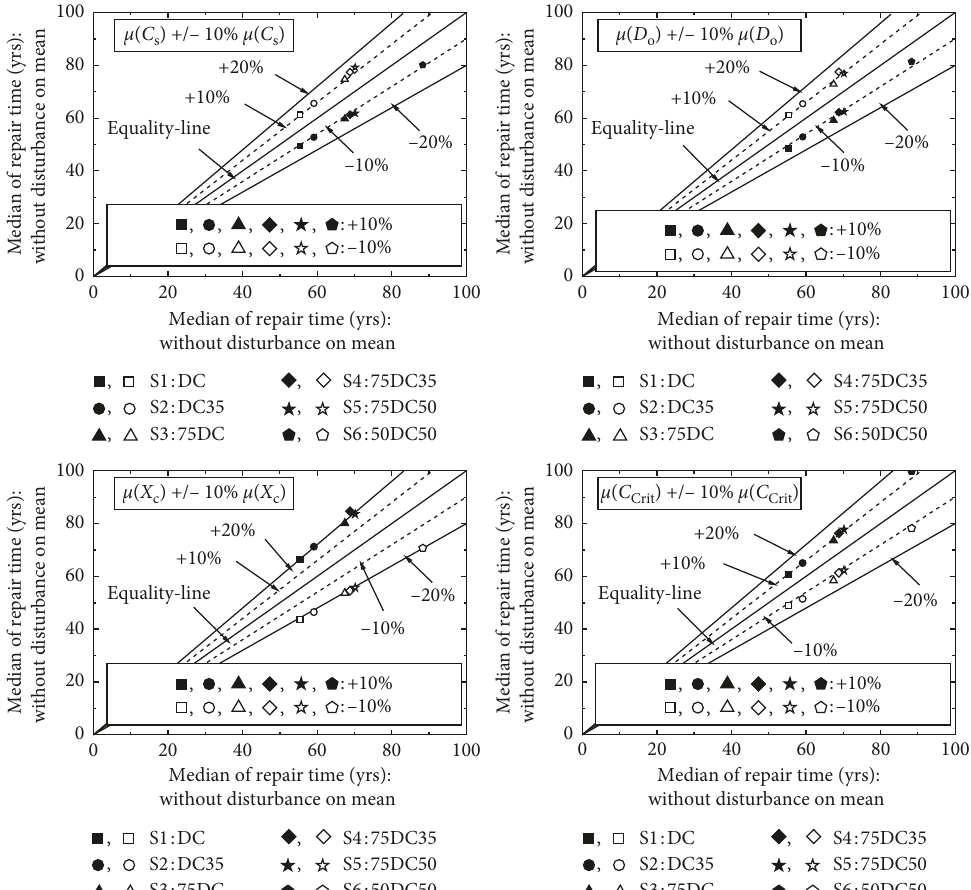
Figure 14: Sensitivity of the mean of four random variables to the median of second repair application